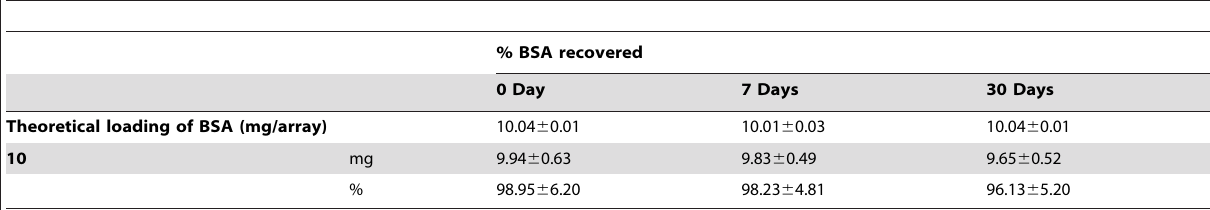
Table 5. Assessment of the total BSA content in the Sodium Alginate (SA) microneedle arrays (MNs) after different storage periods, where the BCA method was used for BSA determination (means 6 S.D., N=3, 8 replicates of each sample).